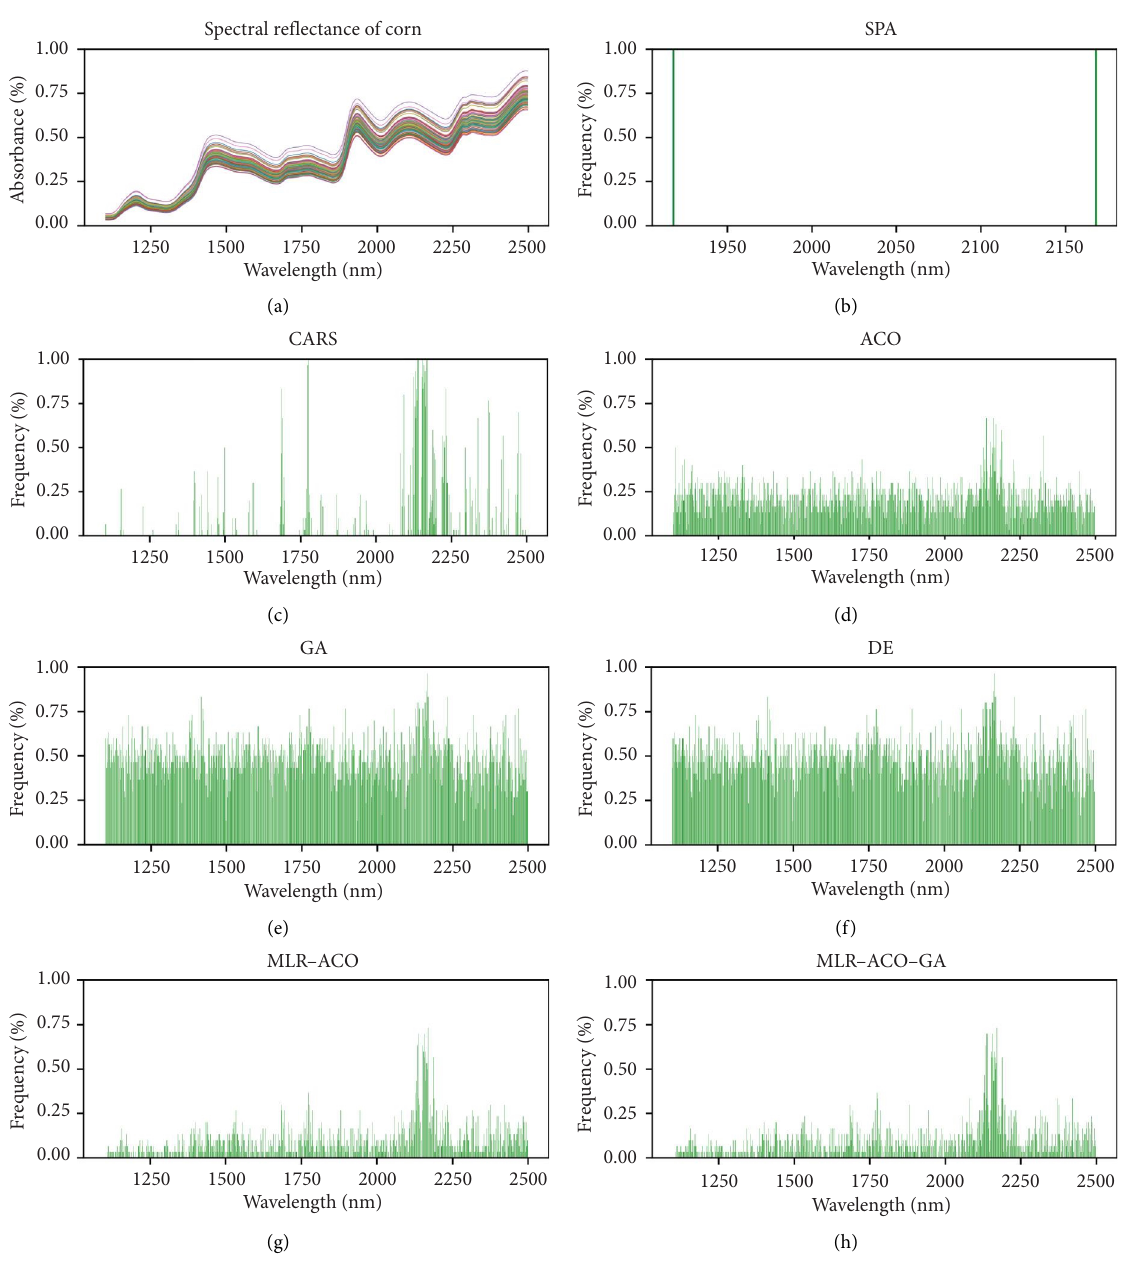
Figure 6: (a): Spectrograms of the corn protein dataset; (b–h) frequencies of variables selected on the grain dataset by diferent wavelength selection methods. (b) SPA, (c) CARS, (d) ACO, (e) GA, (f) DE, (g) MLR-ACO, and (h)